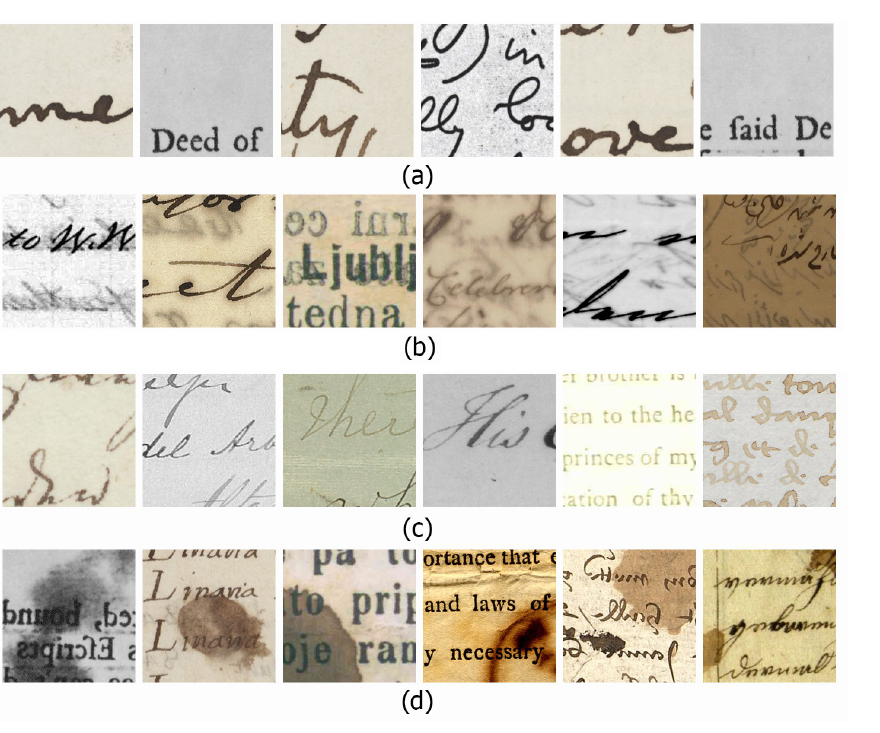
Figure 1. Examples of document images under different degradation [24–32]: ( a ) uniform degra- dation, ( b ) bleed-through-like degradation, ( c ) faint text and low contrast, ( d ) smear or stain or spot